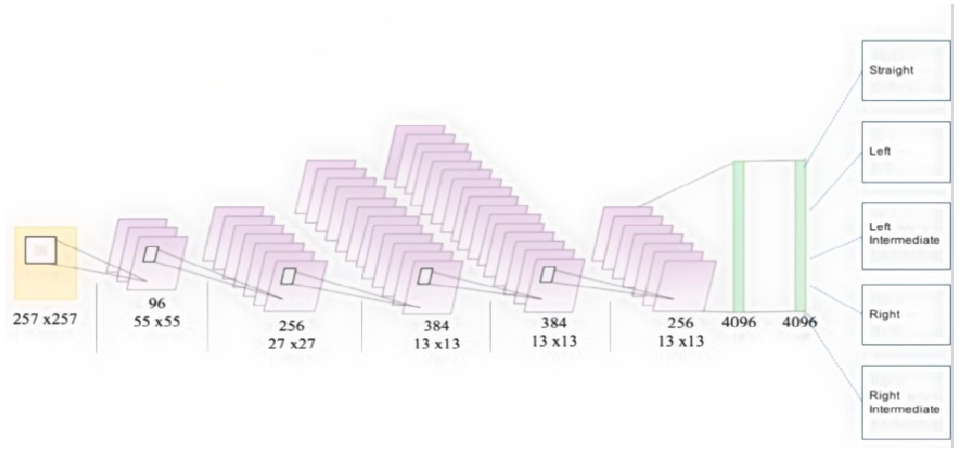
Figure 7. AlexNet method illustrations.